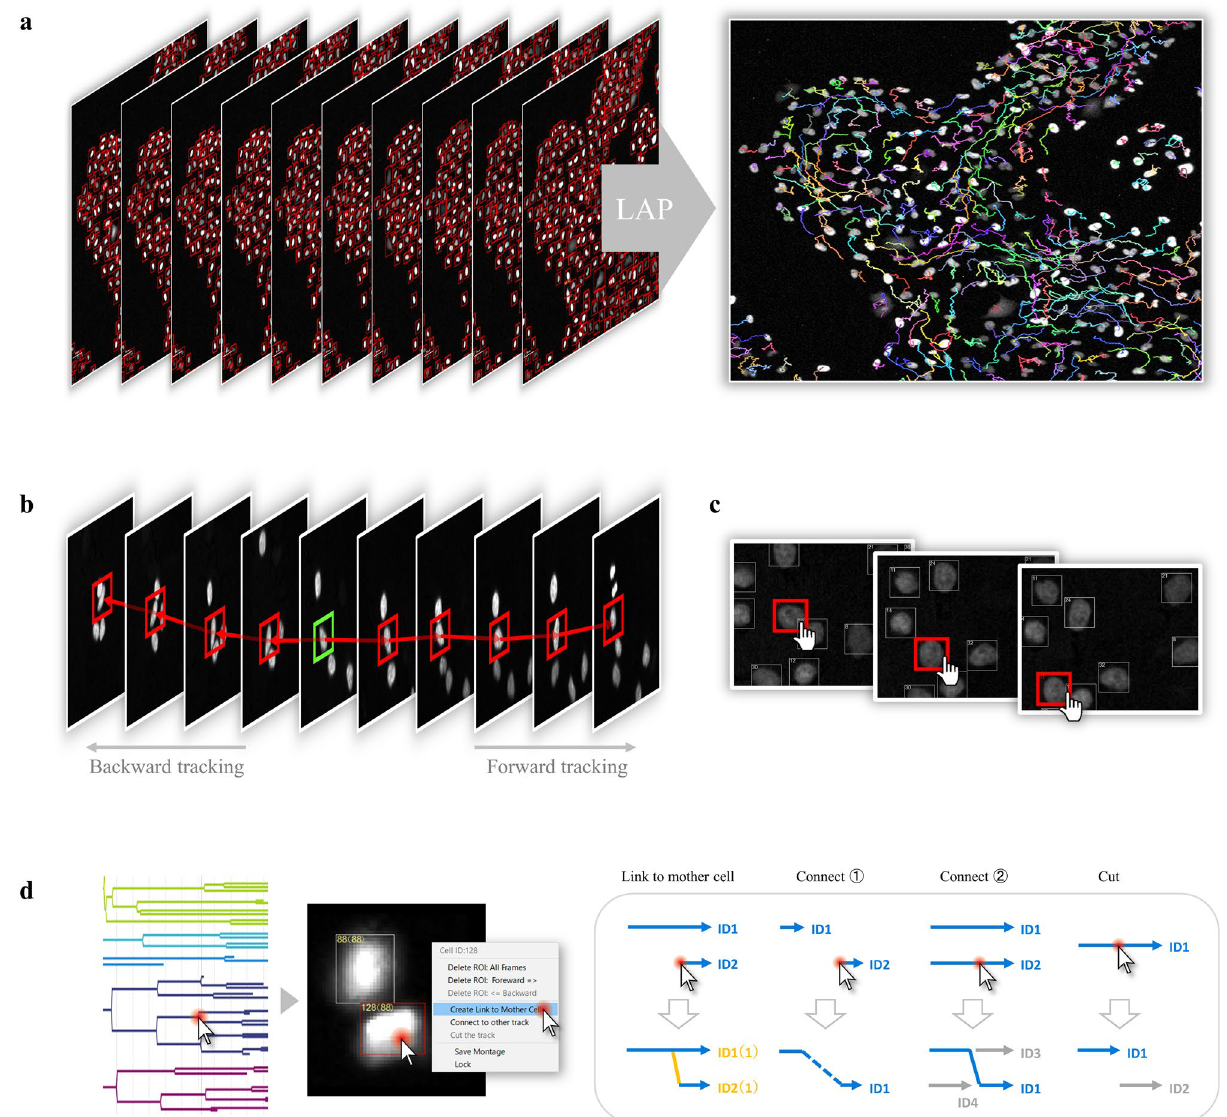
then ROIs are generated. Then, trajectories are generated by linking ROIs that are determined to be identical between adjacent frames. ( b ) Overview of the sequential tracking method. For a user-selected ROI (indicated by the green), the target region for each frame is searched sequentially based on pattern matching to identify the destination location. Time-series forward tracking as well as backward tracking is possible. ( c ) Overview of manual tracking. It is possible to perform manual tracking and generate trajectories for selected ROIs at any timepoint. ( d ) Overview of the trajectory editing function. By clicking on a point of interest in the cell lineage, the corresponding frame image and ROI are instantly displayed. The user can visually check the positional relationship between the source and target ROIs on the image, and modify the trajectory (link relationship between ROIs) with a simple mouse